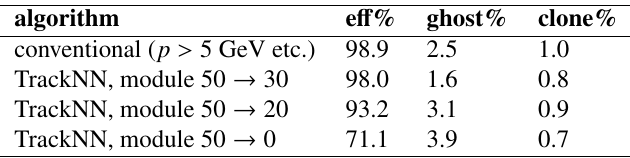
Table 1: Performance Comparison algorithm e ff % ghost% clone% conventional ( p > 5 GeV